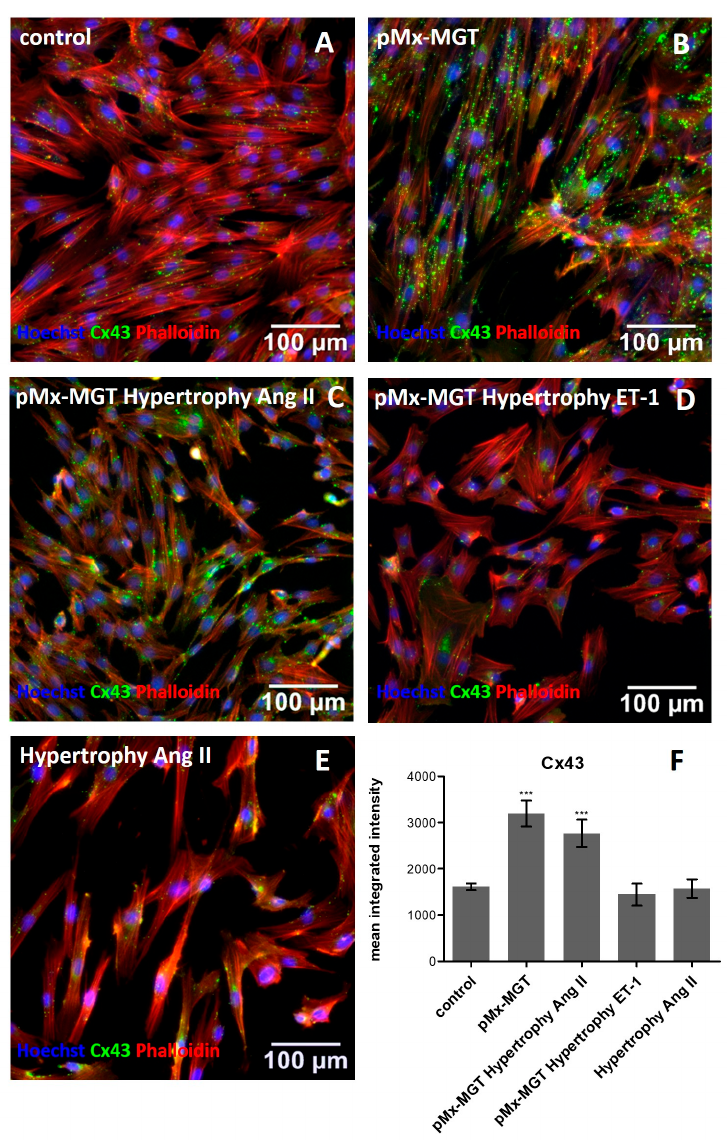
Figure 5. Immunofluorescence staining of Cx43. ( A ) Control cells with mean integrated intensity of 1616.0 ± 315.0 pixels/cell Cx43 (green, F ); ( B , C ) significant changes in pMx-MGT -transfected Isl1 + Sca1 + ckit + pCPCs (3196.0 ± 1224.0 pixels/cell, p = 0.0001) and in combination with Ang II stimulation (2766.0 ± 1324.0 pixels/cell, p = 0.0004). Mean integrated intensities are displayed in ( F ). ( D , E ) Cx43 intensities in pMx-MGT hypertrophy ET-1 (1443.0 ± 977.8 pixels/cell) and hypertrophy Ang II (1572.0 ± 905.5 pixels/cell) cells were not significantly changed compared to control cells. *** p ≤ 0.0004.